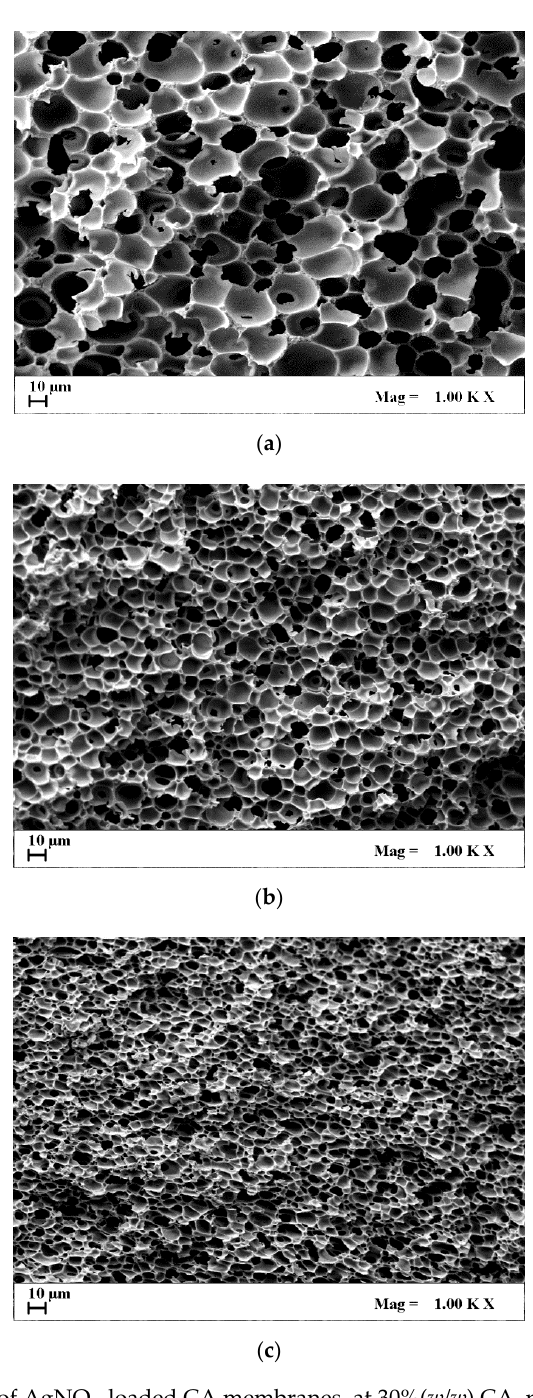
Figure 1. SEM images of AgNO 3 -loaded CA membranes, at 30%(w/w) CA, produced at: ( a ) 150 bar, 55 °C; ( b ) 200 bar, 45 °C; ( c ) 250 bar, 35 °C.